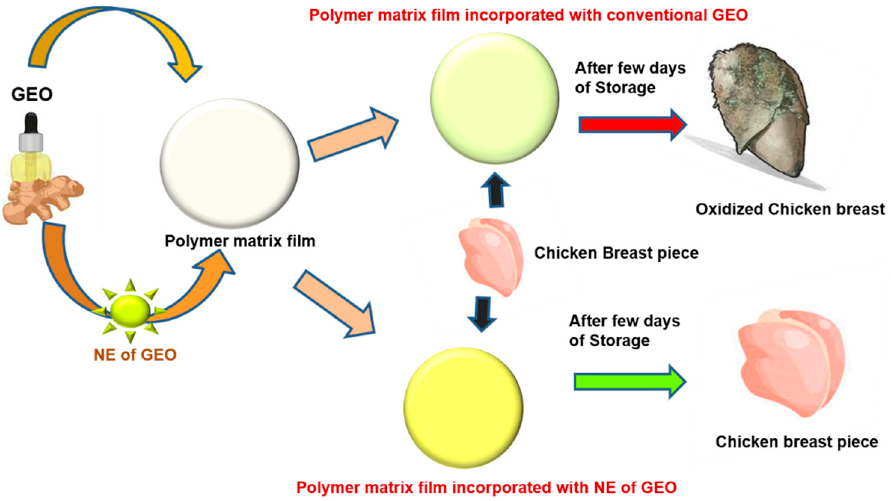
Figure 2. Difference in chicken breast after removal of biodegradable polymer film incorporated with conventional emulsion of ginger oil extract (GEO) and nanoemulsions (NE) of GEO after storage for 5 days.